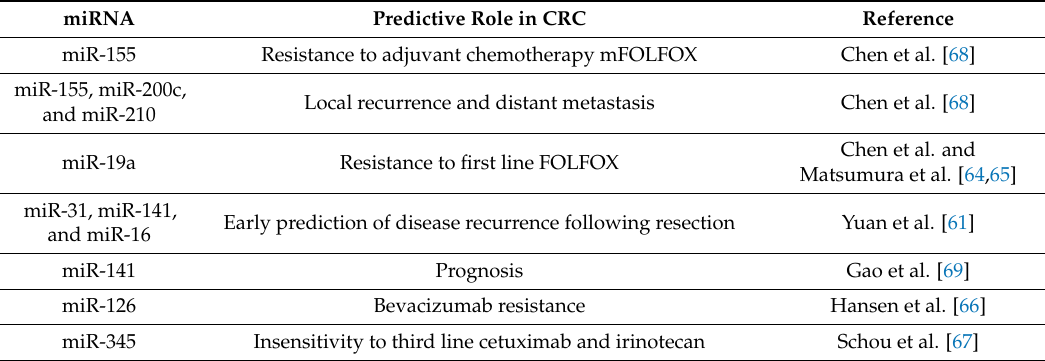
Table 2. miRNAs that influence CRC